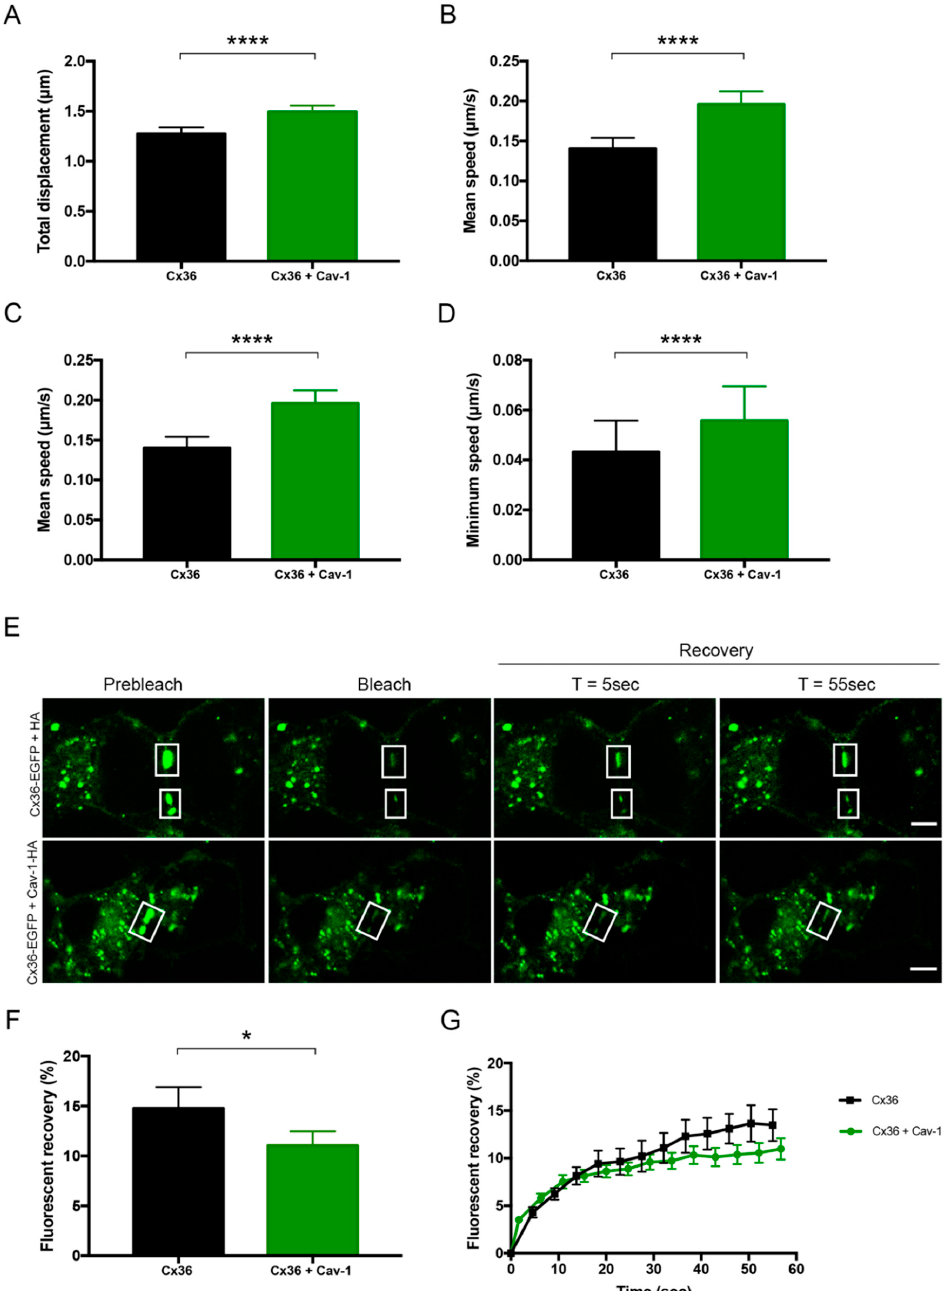
Figure 4. The effect of Cav-1 on vesicular transport and membrane dynamics of Cx36. Total Internal Reflection Fluorescence (TIRF) microscopy was used to resolve the vesicular transport of Cx36-EGFP. Cav-1 significantly amplified displacement ( A ) and the mean ( B ), maximum ( C ), and minimum speed of Cx36 ( D ). Error bars show standard error of the mean. Sample sizes were the following: Cx36-EGFP and HA: n = 1107; Cx36-EGFP and Cav-1-HA: n = 1349. ( E ) FRAP analysis of cells transfected with Cx36-EGFP and HA or Cx36-EGFP and Cav-1-HA showing selected regions (white rectangles) pre bleaching, immediately after bleaching, and recovery 5 and 55 s post bleaching. Scale bar: 5 µ m. ( F ) The bar graph displays the total % fluorescent recovery of the selected gap junction regions, 55 s post bleaching. Error bars show standard error of the mean. Sample sizes were the following: Cx36-EGFP: n = 23; Cx36-EGFP and Cav-1-HA: n = 24. ( G ) Overall trends in % recovery measured every 5 s, over the 55-s duration. Error bars show standard error of the mean. * p < 0.05, **** p <